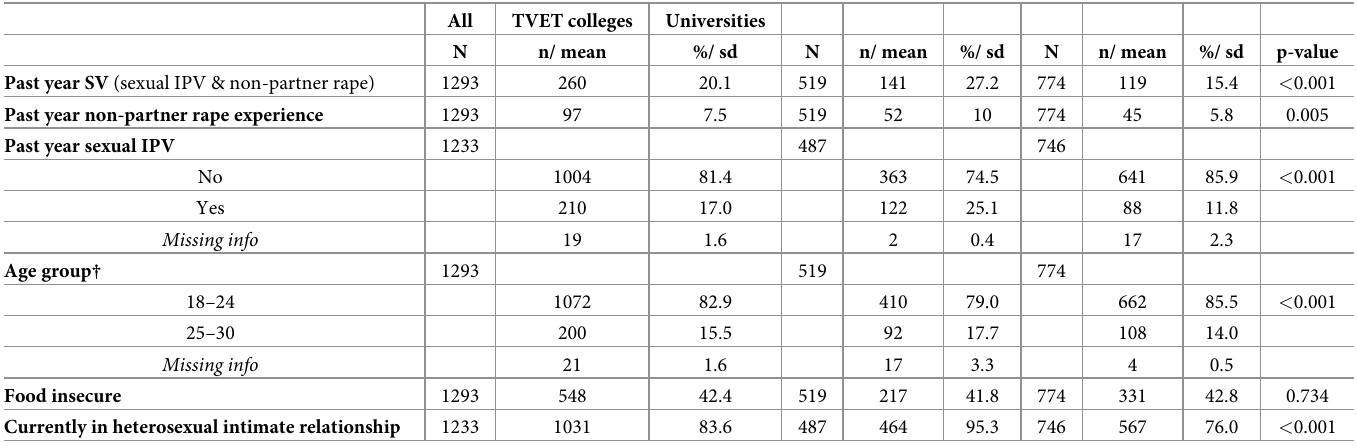
Table 2. Prevalence of past-year SV, socio-demographic characteristics and relationship status of participants disaggregated by institution. Female students survey: South African Technical Vocational Education and Training (TVET) colleges and universities (2018–2019). All TVET